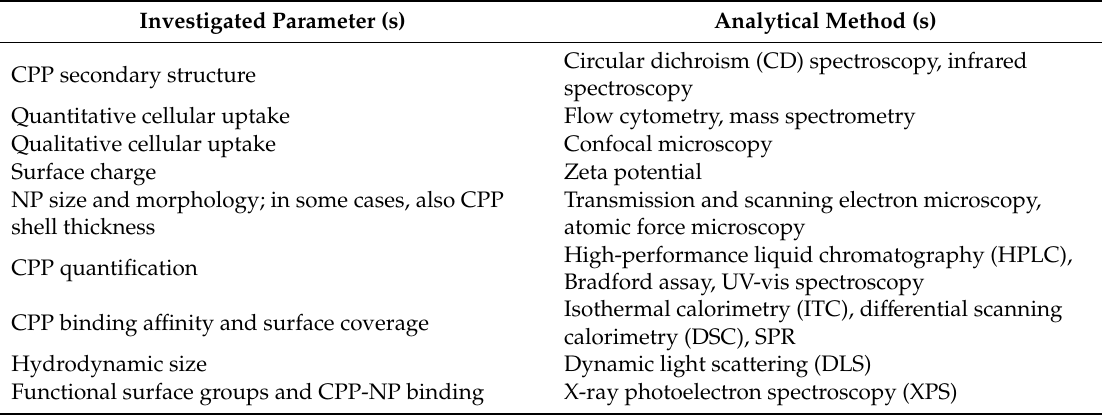
Table 3. Overview of commonly used analytical methods to determine the physicochemical properties of NP-CPP